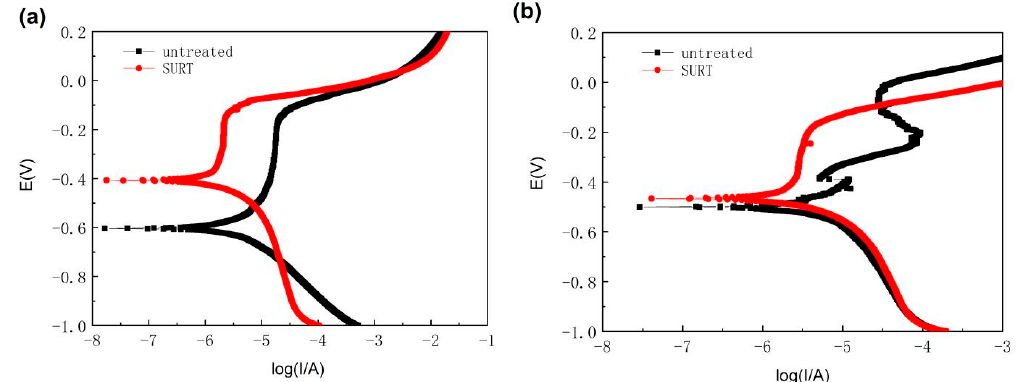
Figure 8. The variation of electric polarization of T4003 ferritic stainless steel welded joint before and after surface ultrasonic rolling. ( a ) Weld zone. ( b ) Base metal. Table 4. Corrosion parameters of the samples derived from Tafel polarization curves.